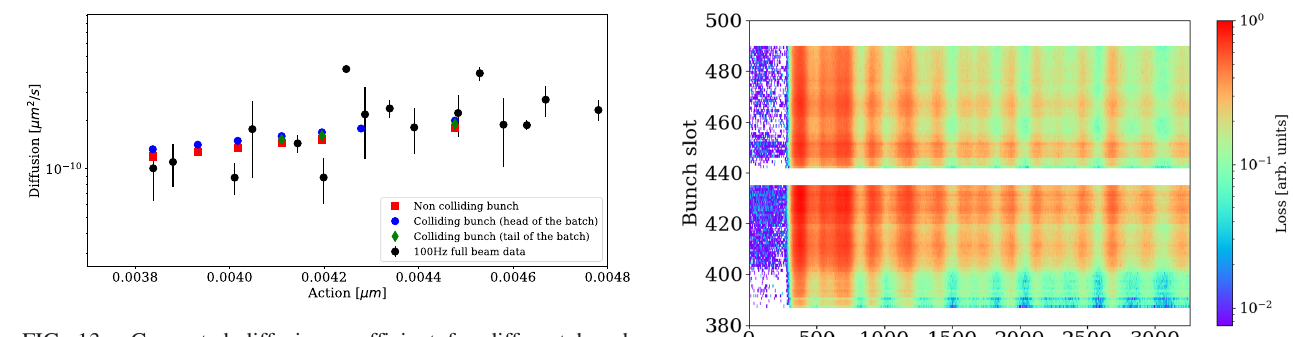
FIG. 13. Computed diffusion coefficient for different bunch families. Results obtained from dBLM acquisition mode 1 (in red, blue, and green) along IC-BLM (black), for fill 6052 (see Table III).